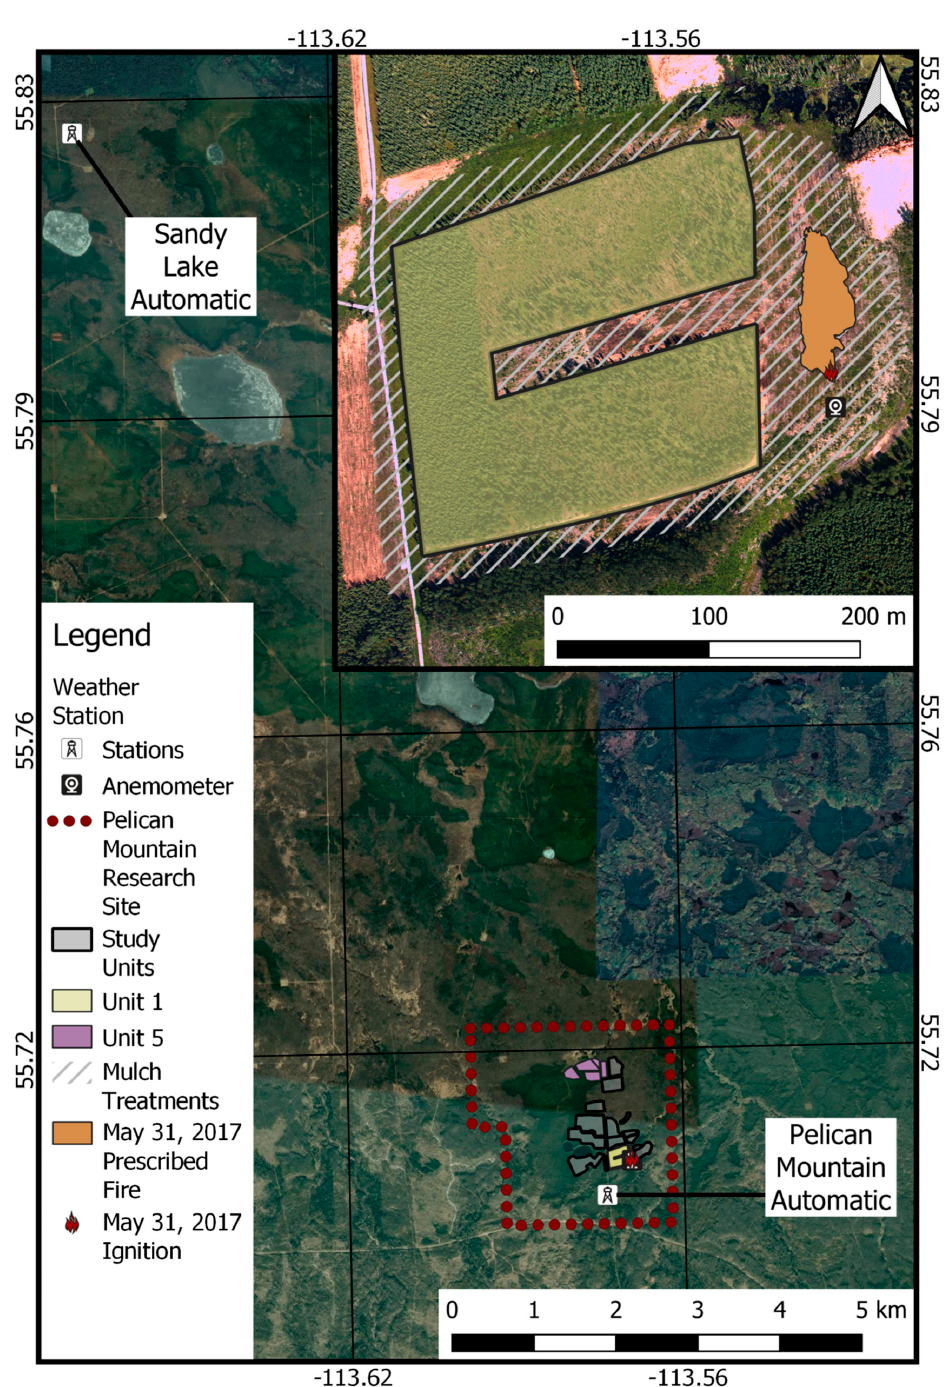
Figure 1. Pelican Mountain Research Site Map—broader pelican mountain research area and local weather stations. Inset—May 31 mulch prescribed fire perimeter to the east of experiment plot Unit 1. The experimental crown fire in Unit 5 conducted in 2019 is described in [8].